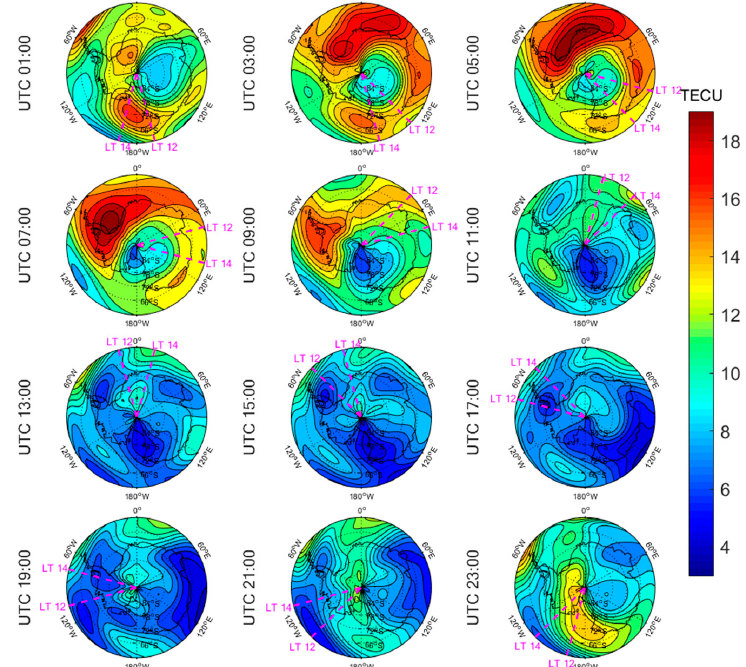
Figure 9. Spatial distribution of mapping TEC of 12 sections under low solar activity year, polar day (DOY 001 in 2010) over the Antarctic. The magenta lines in each subplot represent the longitudes at 12:00 and 14:00 at the middle of the 2 h section of the corresponding subplot.